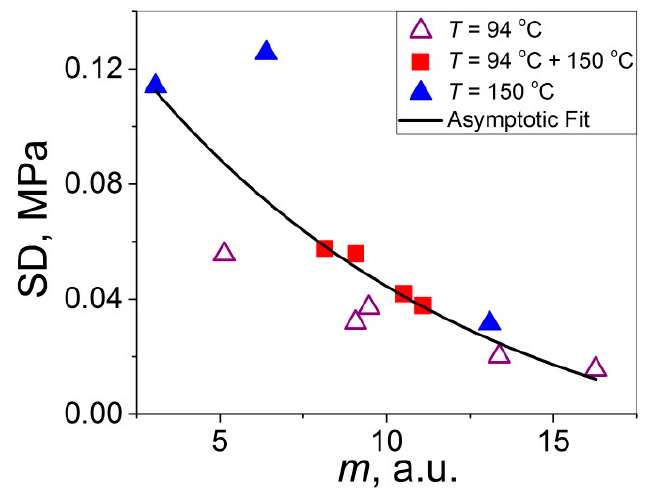
Figure 15. Data of Figure 14a,b plotted as SD vs. m fitted with an asymptotic curve SD = − 0.0264 + 0.187 · 0.908 m ( R 2 = 0.603).